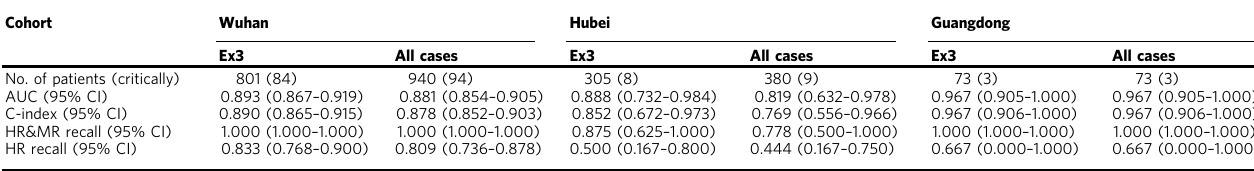
All cases Ex3 All cases